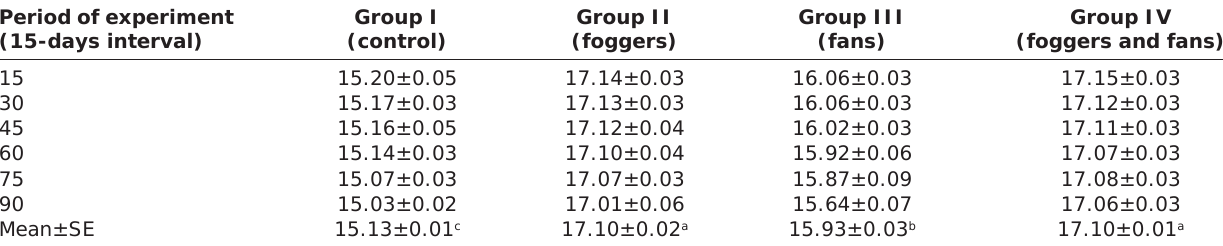
Table-12: Effect of microclimate alteration on milk TS (%) in Murrah buffaloes during summer. Period of experiment (15-days